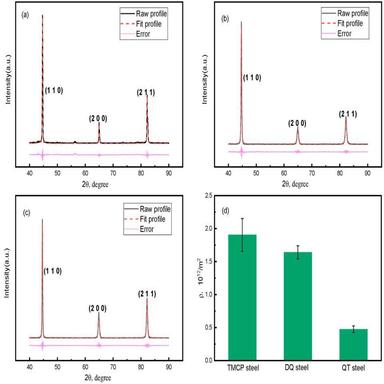
XRD pattern and dislocation density of Ni advanced steels prepared by different processes (a) TMCP steel, (b) DQ steel, (c) QT steel, (d) Dislocation density.